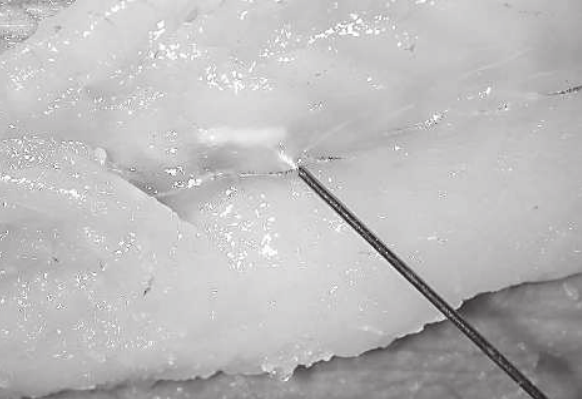
Fig. 1. - Larve de Diphyllobothrium latum encapsulée dans un filet de perche.